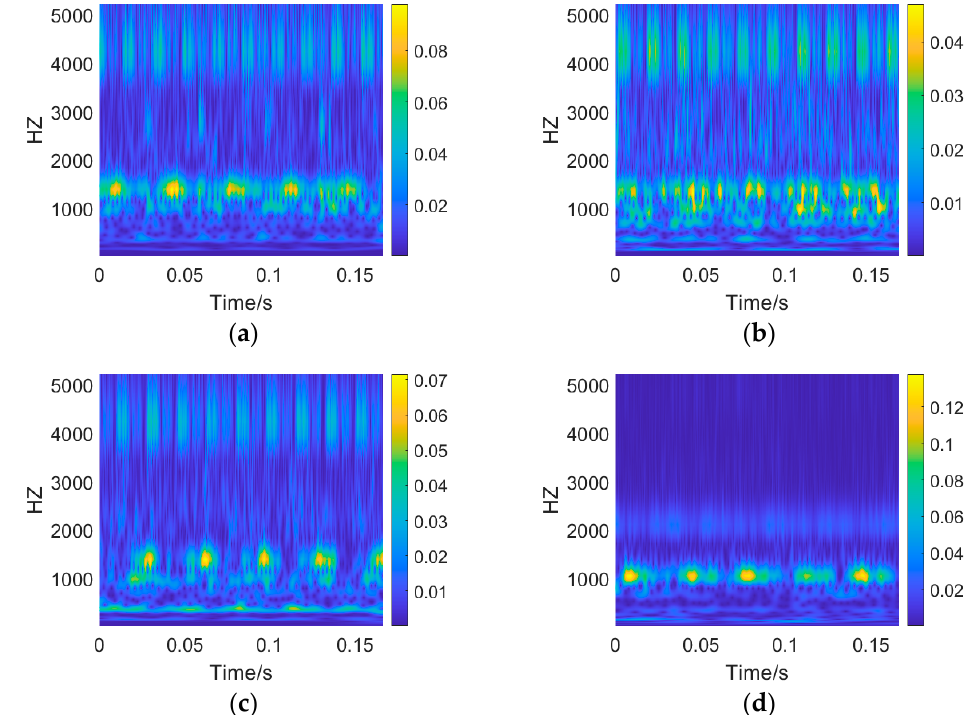
Figure 7. Wavelet transform time–frequency diagram of fault and normal state time series for: ( a ) valve body leakage fault, ( b ) sealing surface leakage fault, ( c ) electric device fault and ( d ) normal signals.